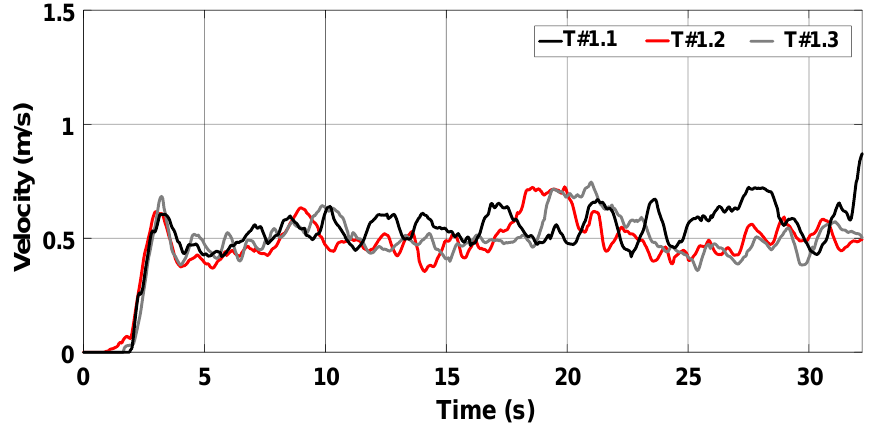
Figure 17. Velocity of the electric tractor during the trial sessions carried out on firm soil and without slip control.